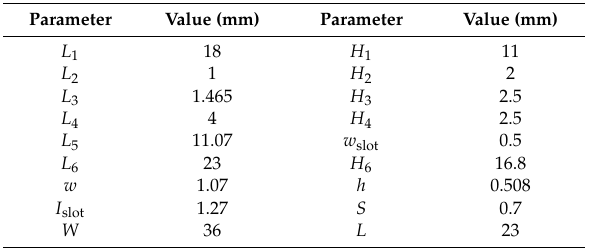
Table 1. Parameter values of the ultra-wideband (UWB)